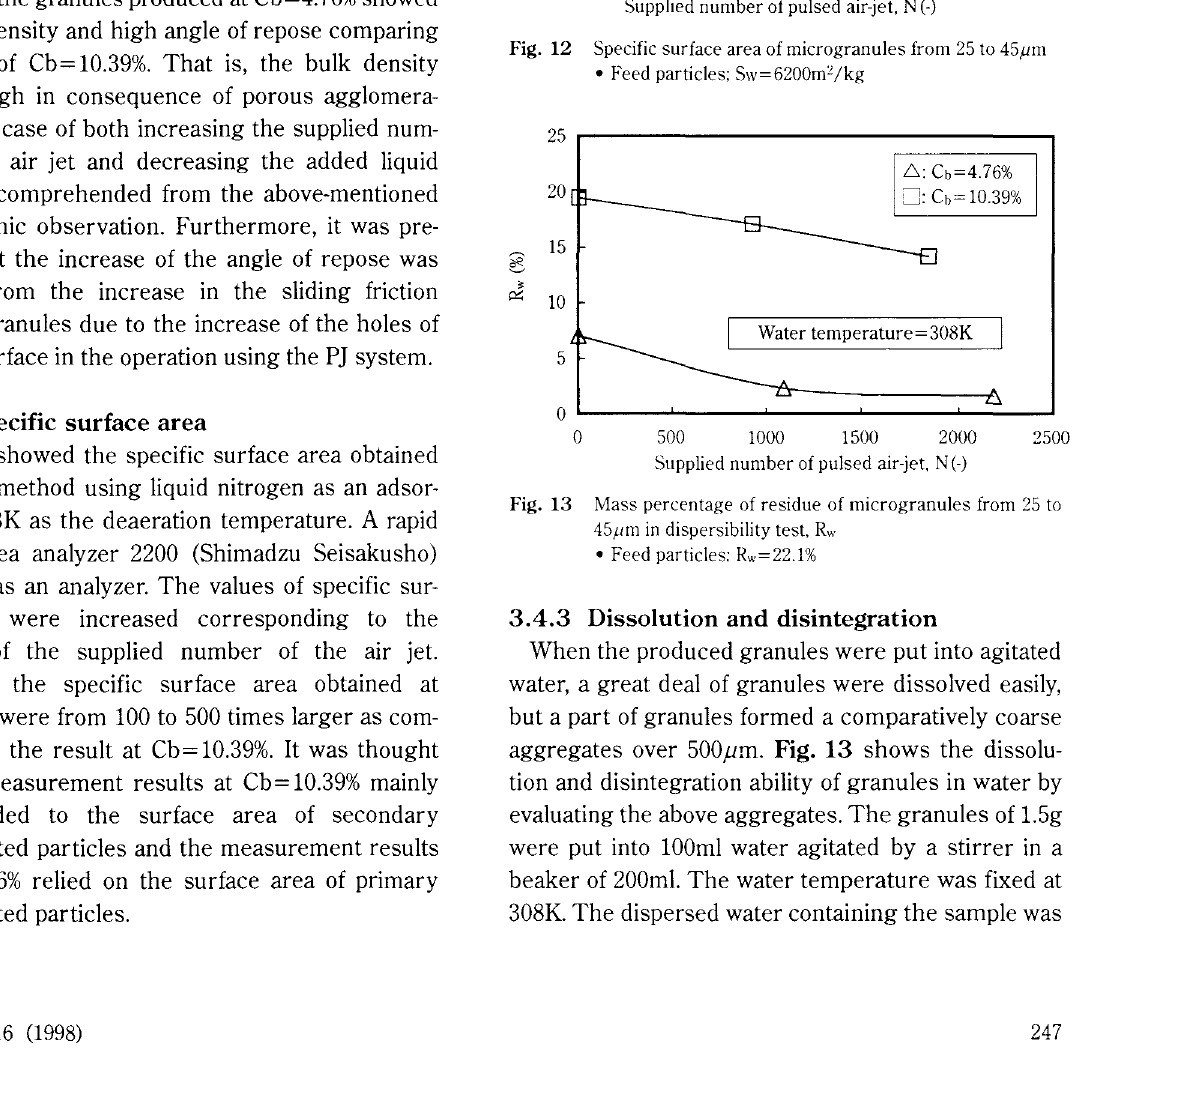
Fig. 12 Specific surface area of micro granules from 25 to